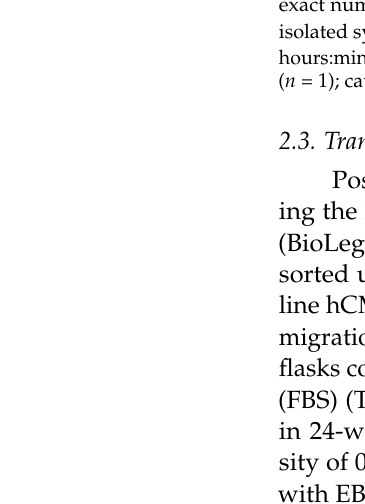
Abbreviations: Healthy = healthy individuals and controls; MS (No Tx) = treatment-naive multiple sclerosis; NTZ-MS = multiple sclerosis patients who were treated for 18 months with and clinically responded to natal- izumab treatment; MP = methylprednisolone; NA = not applicable. a Cohorts were used for transcription factor, granzyme and chemokine receptor expression screens, cytokine-production screens or transmigration assays (see exact numbers in figure legends). b Diagnosis according to the McDonald 2017 criteria. c Time from clinically isolated syndrome diagnosis to sampling. d Dimethyl fumarate, Interferon β 1a or glatiramer acetate. e Given